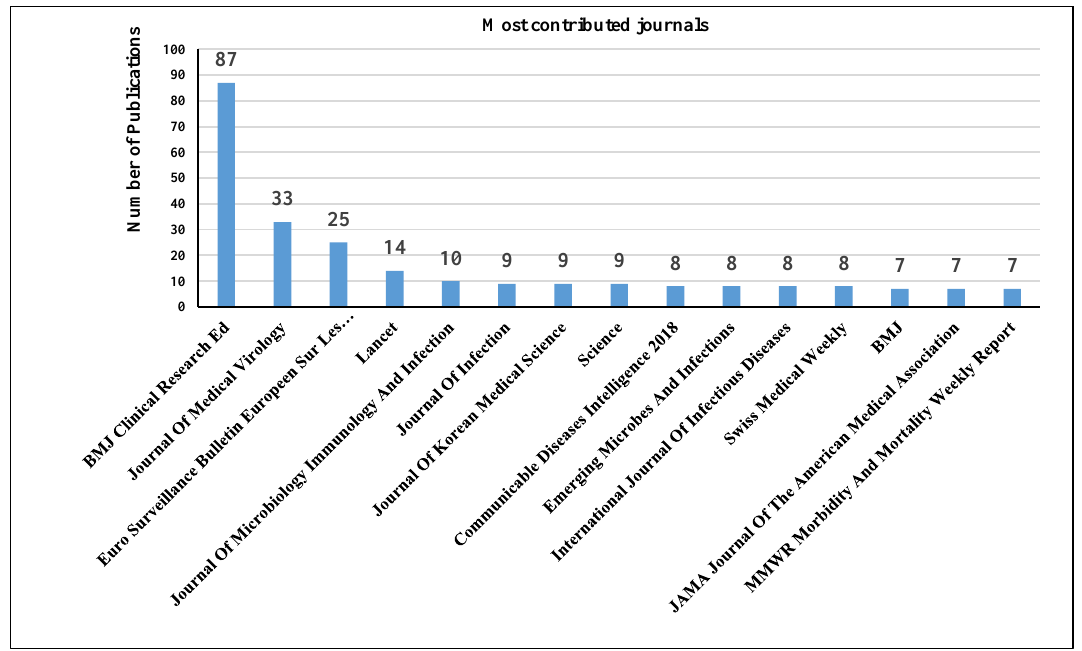
Figure 3. Most contributed journals in the field of COVID-19